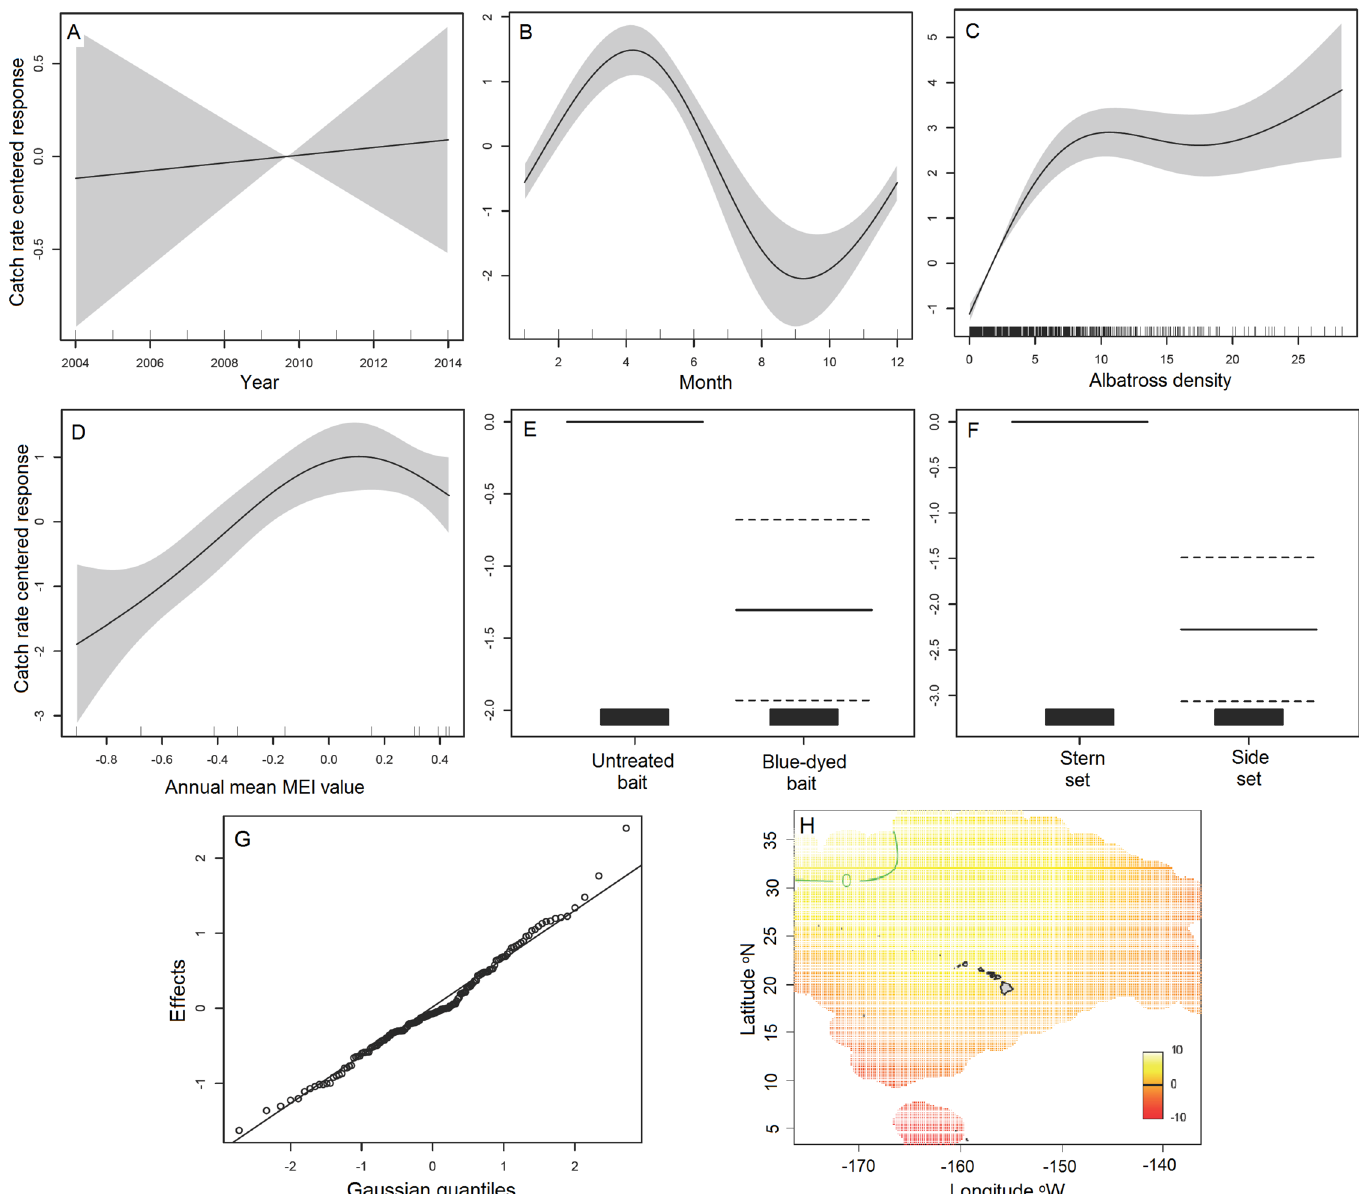
Fig 1. Graphical summary of geoadditive GAMM analysis, Hawaii longline tuna fishery, 2004 – 2014. The response variable, seabird catch rate, is shown on the y-axis as a centered smoothed function scale to ensure valid pointwise 95% confidence bands. Covariates and factors are shown on the x-axis: (A) year, (B) month, (C) mean albatross density during setting and hauling, (D) annual mean MEI value, (E) untreated vs. blue-dyed bait, (F) side vs. stern setting, (G) quantile plot of random effects for the 154 vessels, and (H) structured spatial effect for all 11 years combined. Color scale units in (H) represent centered scale values. For covariates, solid curves are the smoothing spline fits conditioned on all other covariates and factors, and the shaded areas are bounded by pointwise 95% confidence curves around the fit in each panel. For factors, solid bars are the mean, dashed bars are the 95% confidence interval, and the first factor is the reference level, which is centered at zero on the y-axis. Vertical ticks or rug on the x-axis in each panel show the data